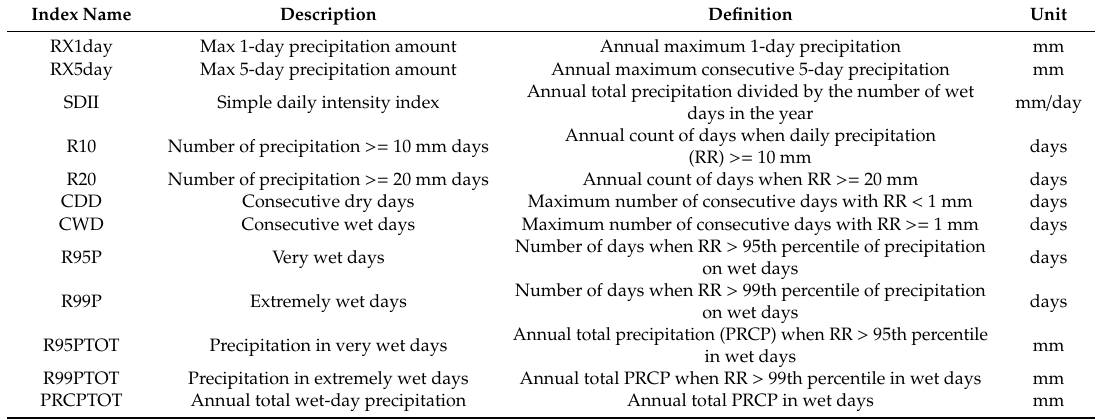
Table 2. List of twelve extreme precipitation indices used in this